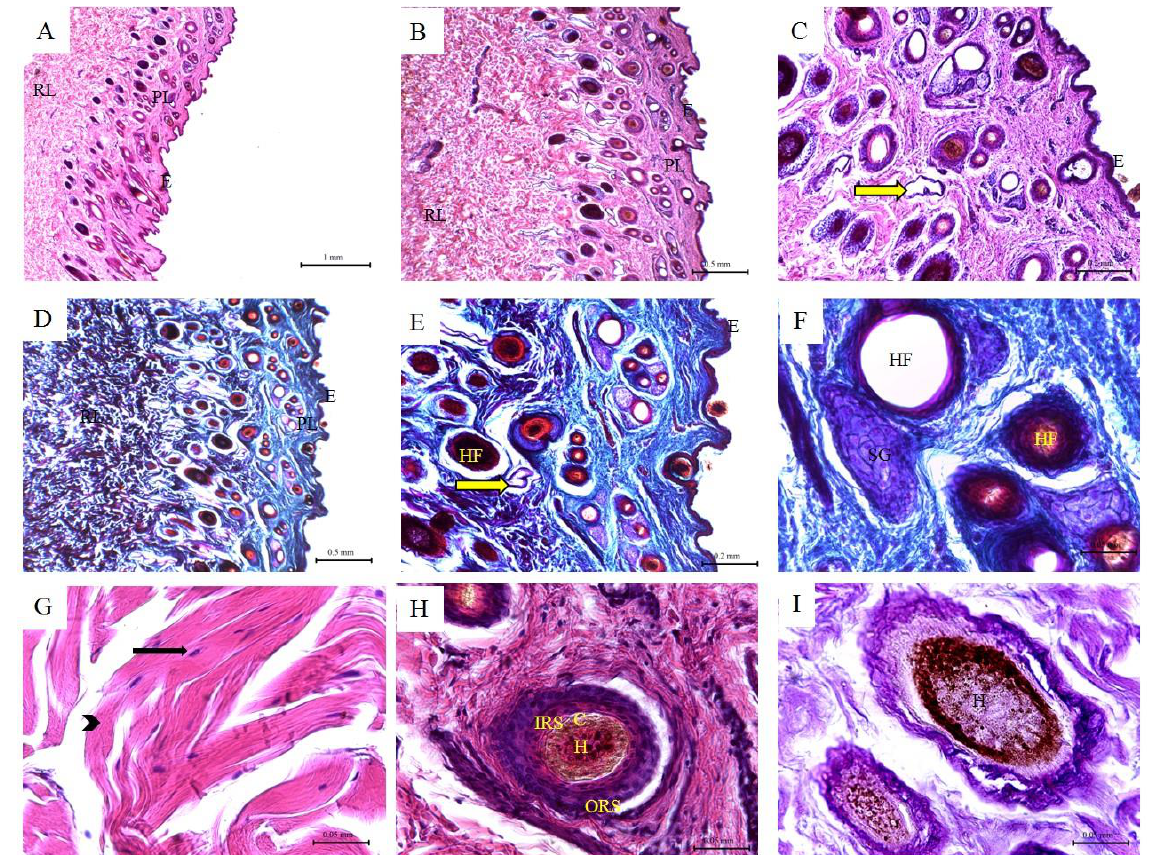
Figure 4: Histological features of sheep skin. Hematoxylin and eosin staining ( A-C ; G-H) ; Cross- man's trichrome staining ( D-F) ; and PAS staining ( I ) of sheep skin tissue sections. (E) Keratinized stratified squamous epithelium of the epidermis; (PL) Papillary layer of the dermis; (RL) Reticular layer of the dermis; (NT) Nervous tissue; (SG) Sebaceous glands; (Black arrow) fibrocytes; (Arrow heads) collagen bundles of the reticular layer; (Yellow arrow) Sweat glands; (HF) Hair follicles; (H) Hair; (C) Cuticle; (IRS) Inner root sheath; (ORS) Outer root